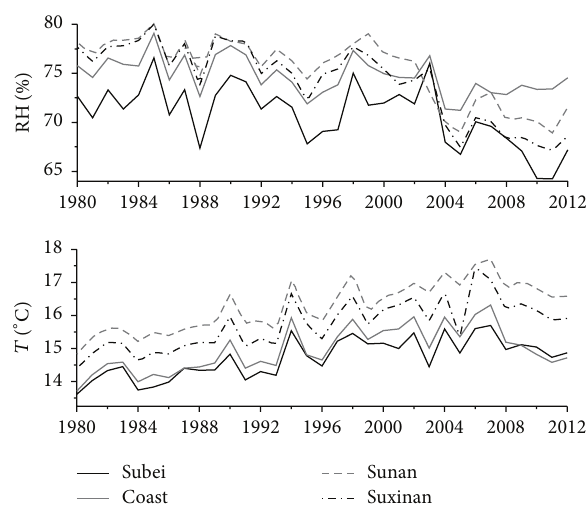
Figure 10: Average annual temperature and relative humidity in Jiangsu Province.